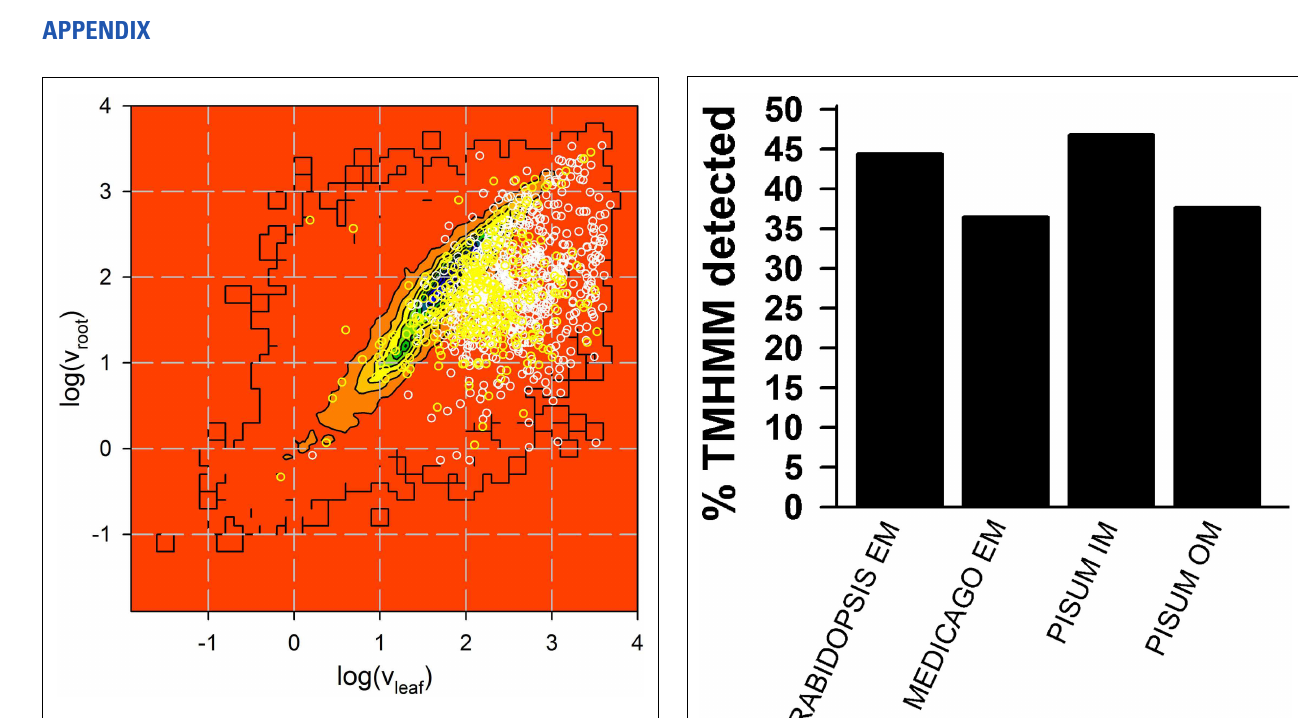
FIGUREA1 |Analysis of expression of genes coding for identified proteins. Expression of 735 genes coding for proteins identified by more than one peptide (white) and 322 genes coding for proteins identified by one peptide only (yellow) in roots and leaves was analyzed by Affymetrix (Vojta et al., 2004). Shown is the Affymetrix value in logarithmic scale for all genes previously analyzed as contour plot (from low (red) to high (blue) number of genes identified with a certain expression distribution) and the distribution of the genes coding for the proteins identified as circles.